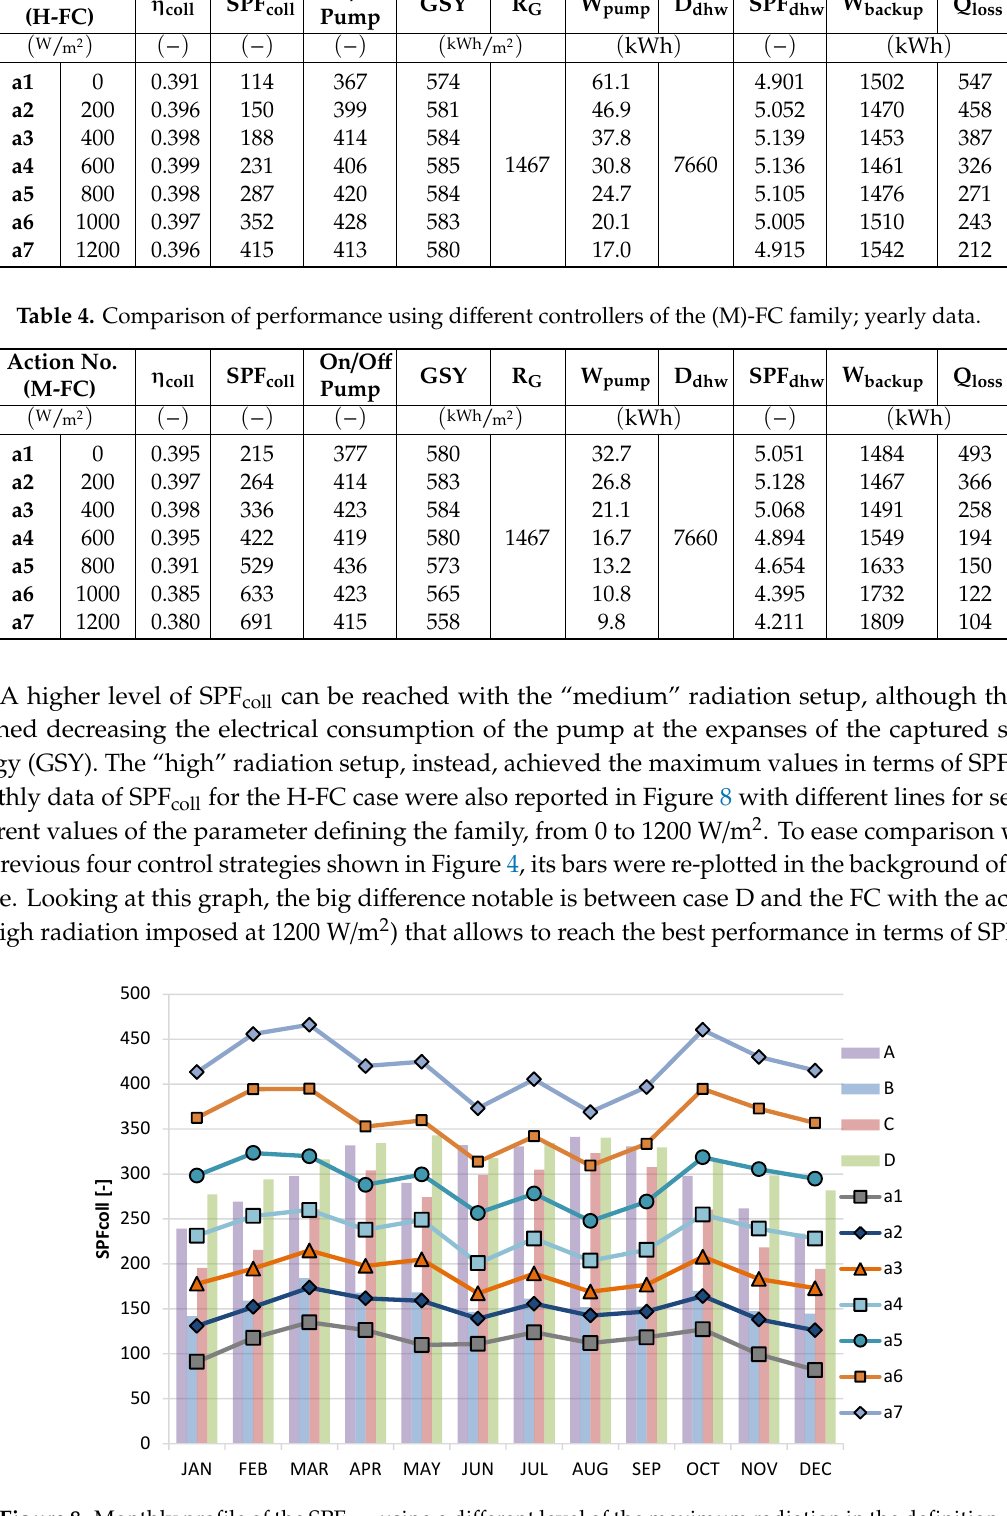
Table 3. Comparison of performance using di ff erent controllers of the (H)-FC family; yearly data. Action No.